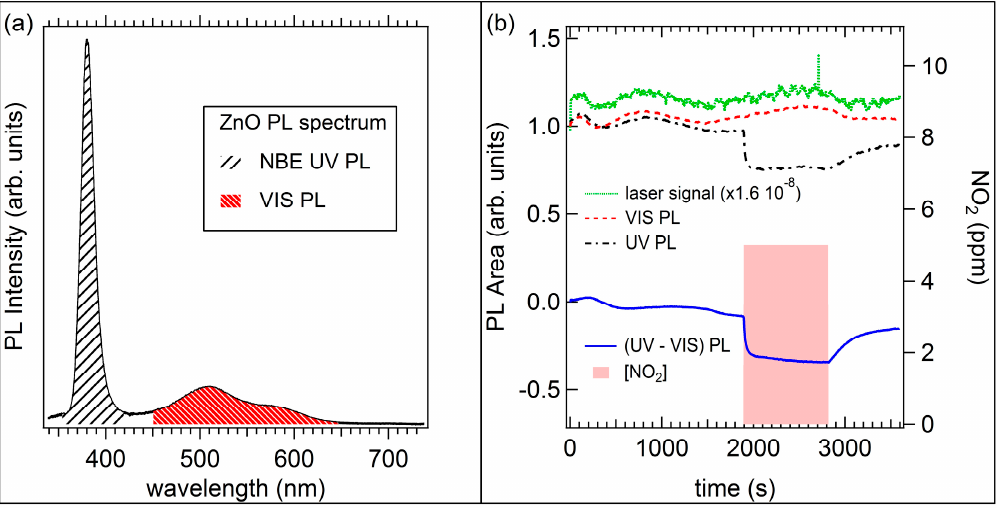
Figure 10. ( a ) Photoluminescence (PL) spectrum of ZnO NWs with ultraviolet Near Band Edge (NBE) and visible emission; ( b ) PL optical response to 5 ppm nitrogen dioxide gas.